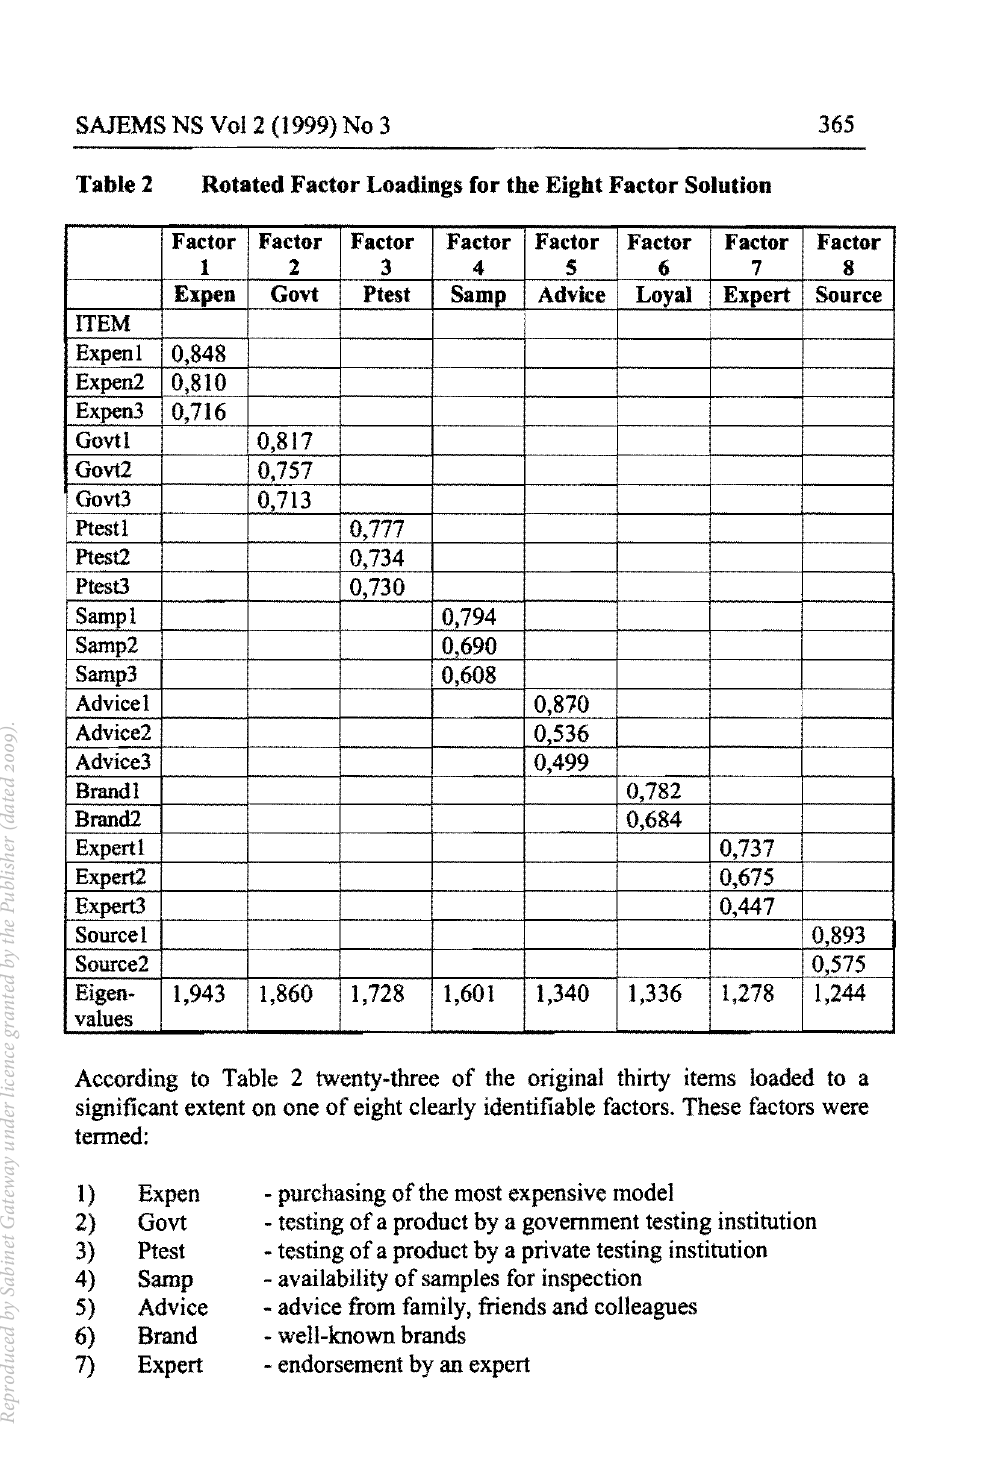
Table 2 Rotated Factor Loadings for the Eight Factor Solution Factor Factor Factor Factor Factor Factor Factor Factor Samp Advice Loyal Expert